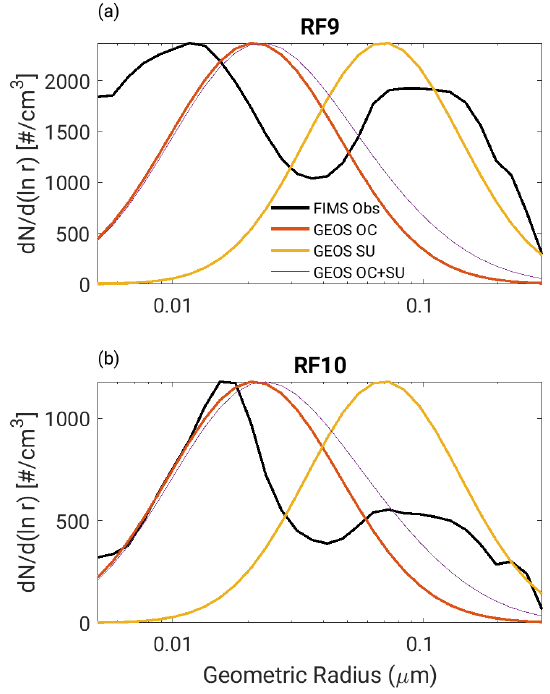
Figure 13. The observed dry aerosol size distribution from FIMS for data points classified as a biomass burning regime from (a) RF9 and (b) RF10. Also shown is the assumed particle size distribution for organic carbon and sulfate in GEOS, scaled to match the peak in the observed distributions, as well as those distributions linearly added for a more direct comparison between GEOS and